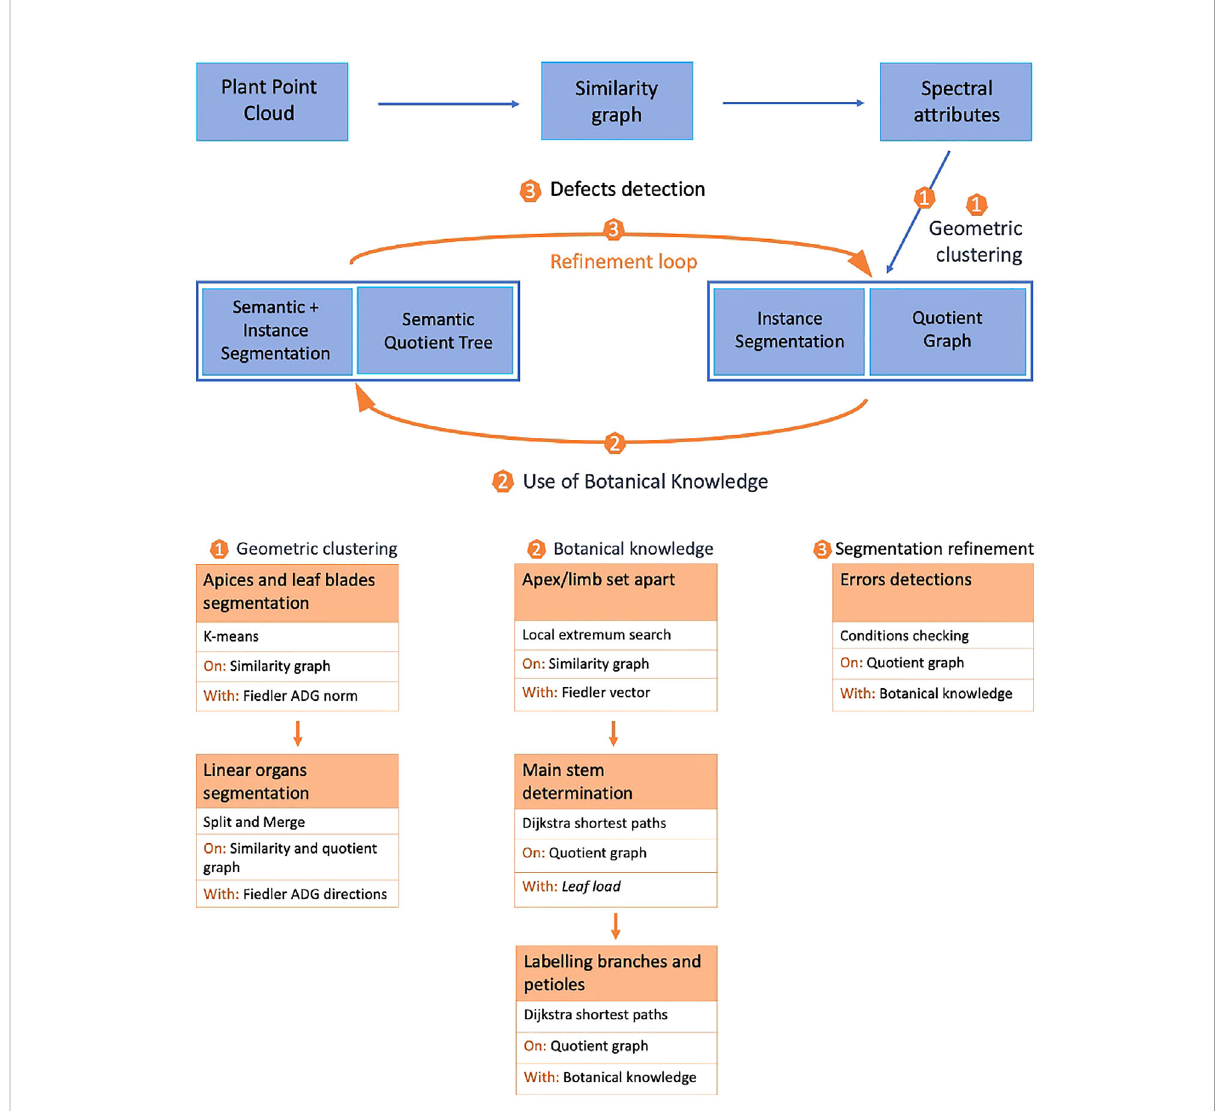
FIGURE 2 General principle of the mixed instance/semantic segmentation